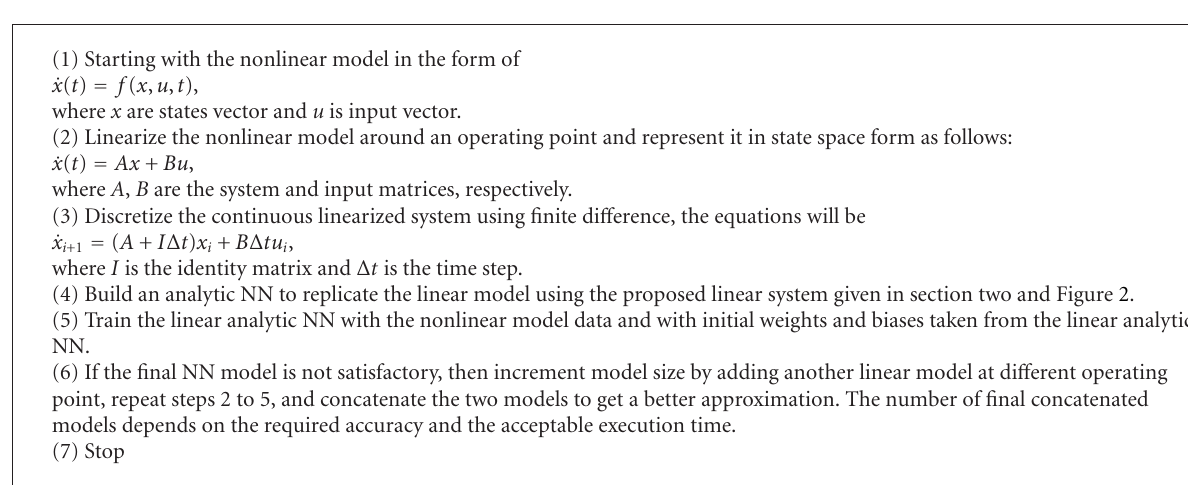
Algorithm 1: NN algorithm for modeling nonlinear